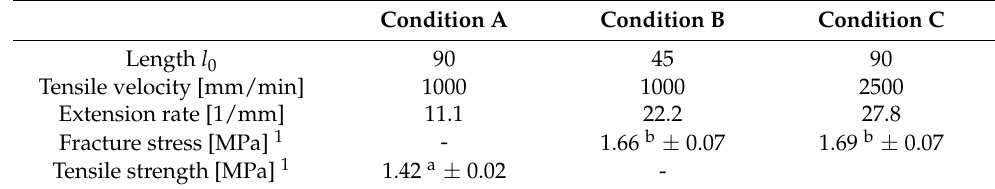
Table 1. Effects of specimen length and tensile velocity on fracture properties ( T = 25 ◦